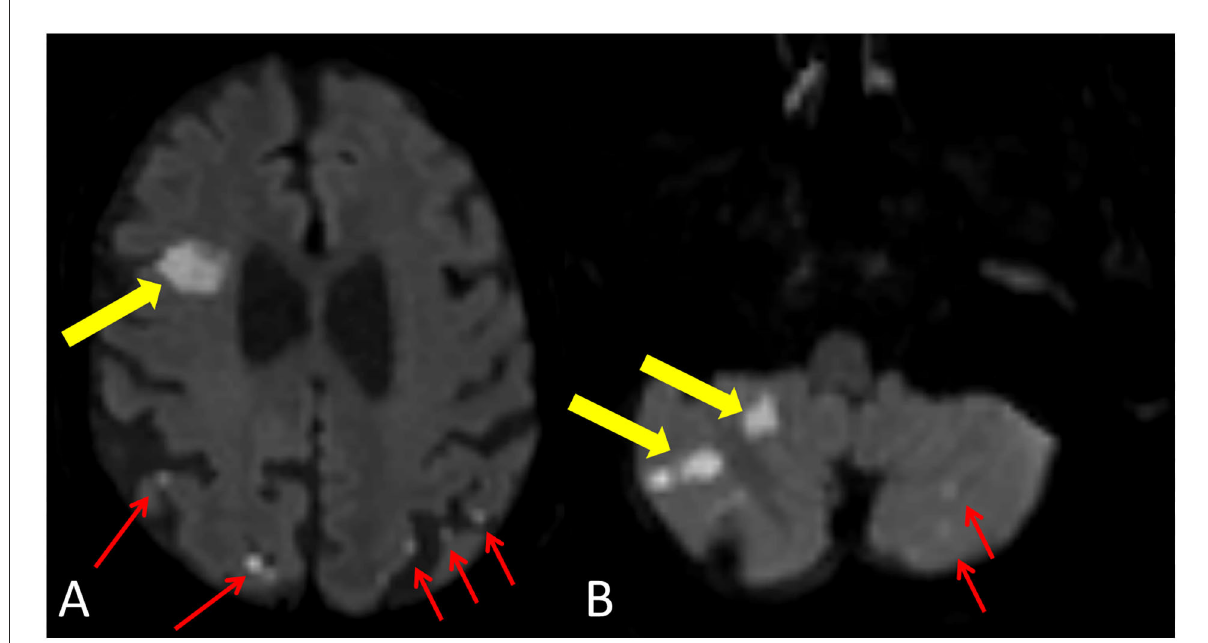
FIGURE3 New ischemic lesion after TAVI. Yellow arrows demonstrate a larger lesion with restricted diffusion in the right frontal lobe (A) and in the right cerebellar hemisphere (B) . Red arrows show smaller cortical-subcortical lesions with restricted diffusion in the left and right parietal lobes (A) and in the left cerebellar hemisphere (B)